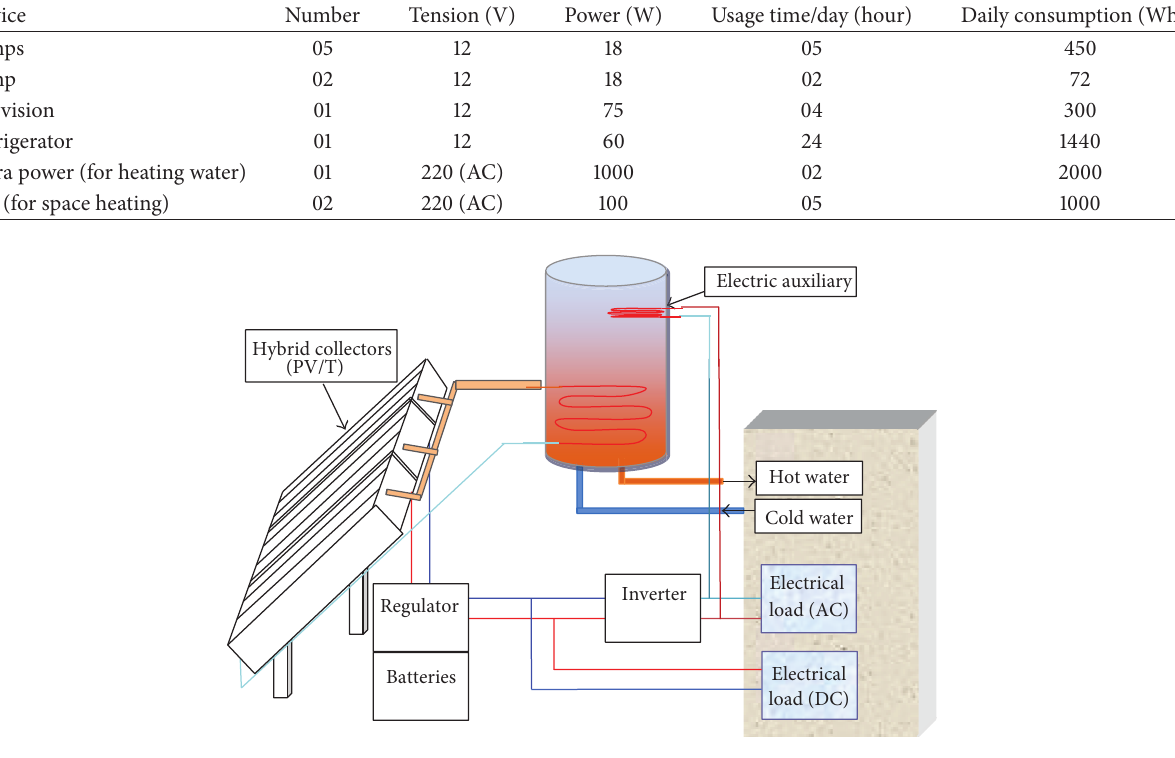
Figure 6: Diagram of the energy system based on collectors PV/T applied to